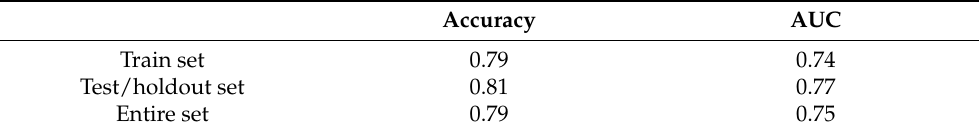
Table 3. Logistic regression model performance metrics on the train and test datasets.